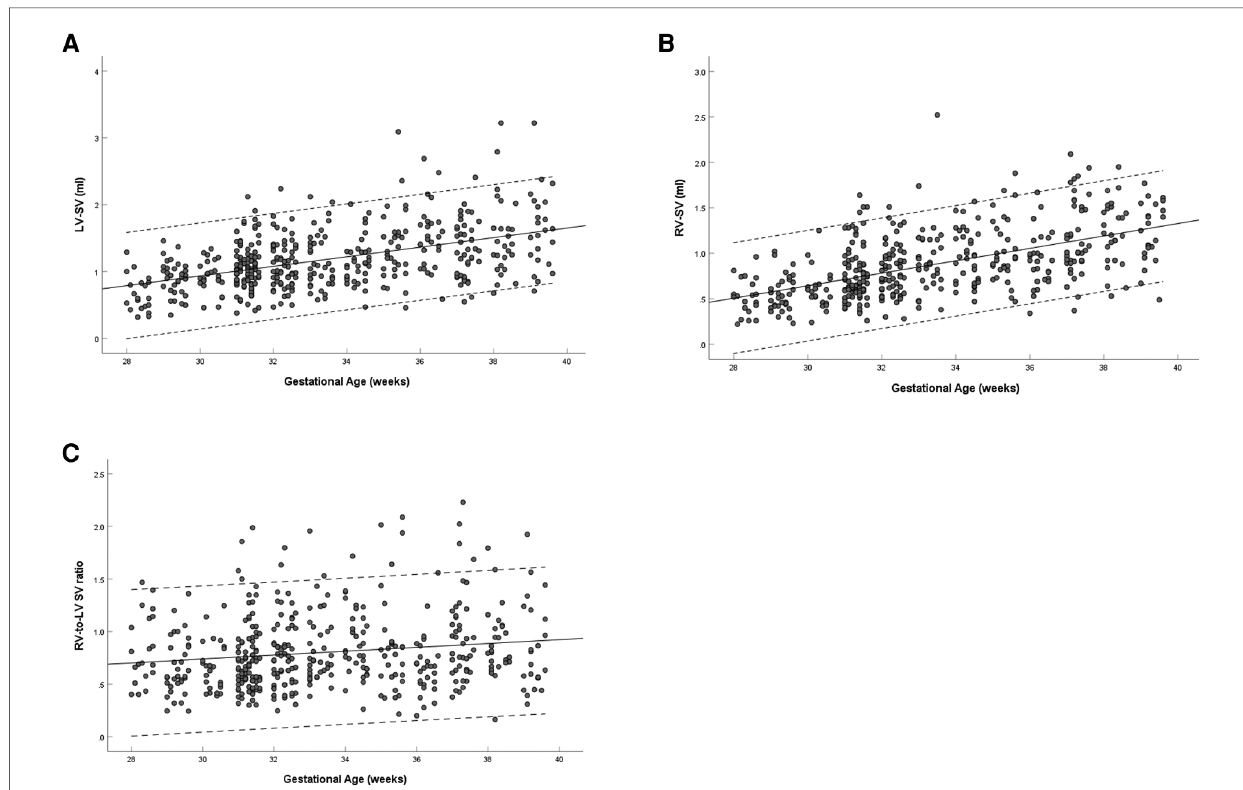
FIGURE 6 Scatterplots of left ventricular SV ( A ), right ventricular SV ( B ), and right-to-left ventricular SV ratio ( C ), according to gestational age (weeks), in 453 low-risk singleton pregnancies from 28 to 39 weeks gestation. Regression lines with the 5% and 95% con fi dence intervals are plotted with the regression equation. LV, left ventricle; RV, right ventricle; SV, stroke